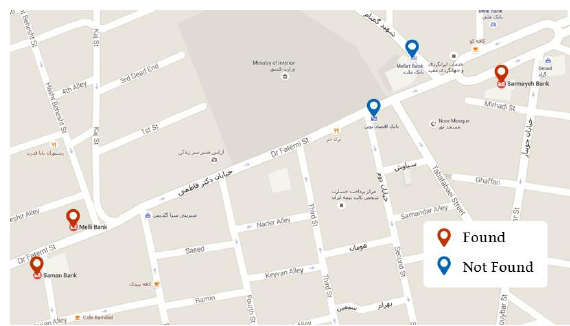
Figure 1. Result of Search “Fatemi-Bank” in Google